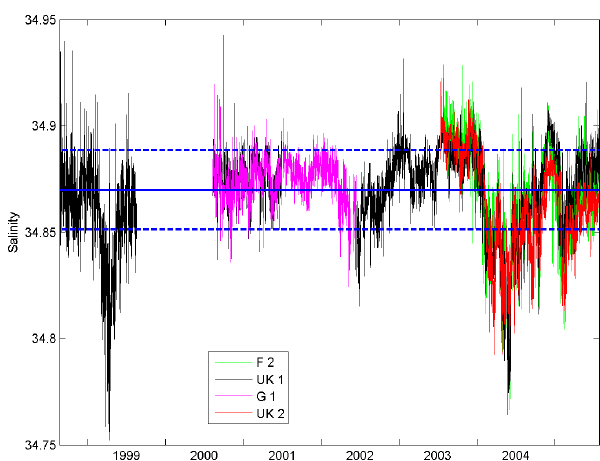
Fig. 3. Salinity time series from the Angmagssalik array Sea-Bird MicroCATs (Dickson et al., 2008). Data have been binned into 1-hour means from the original 10-minute sampling rate. Solid blue line represents the mean of the time series, and dotted blue lines represent plus and minus 1 standard deviation. Tidal signals have been removed.